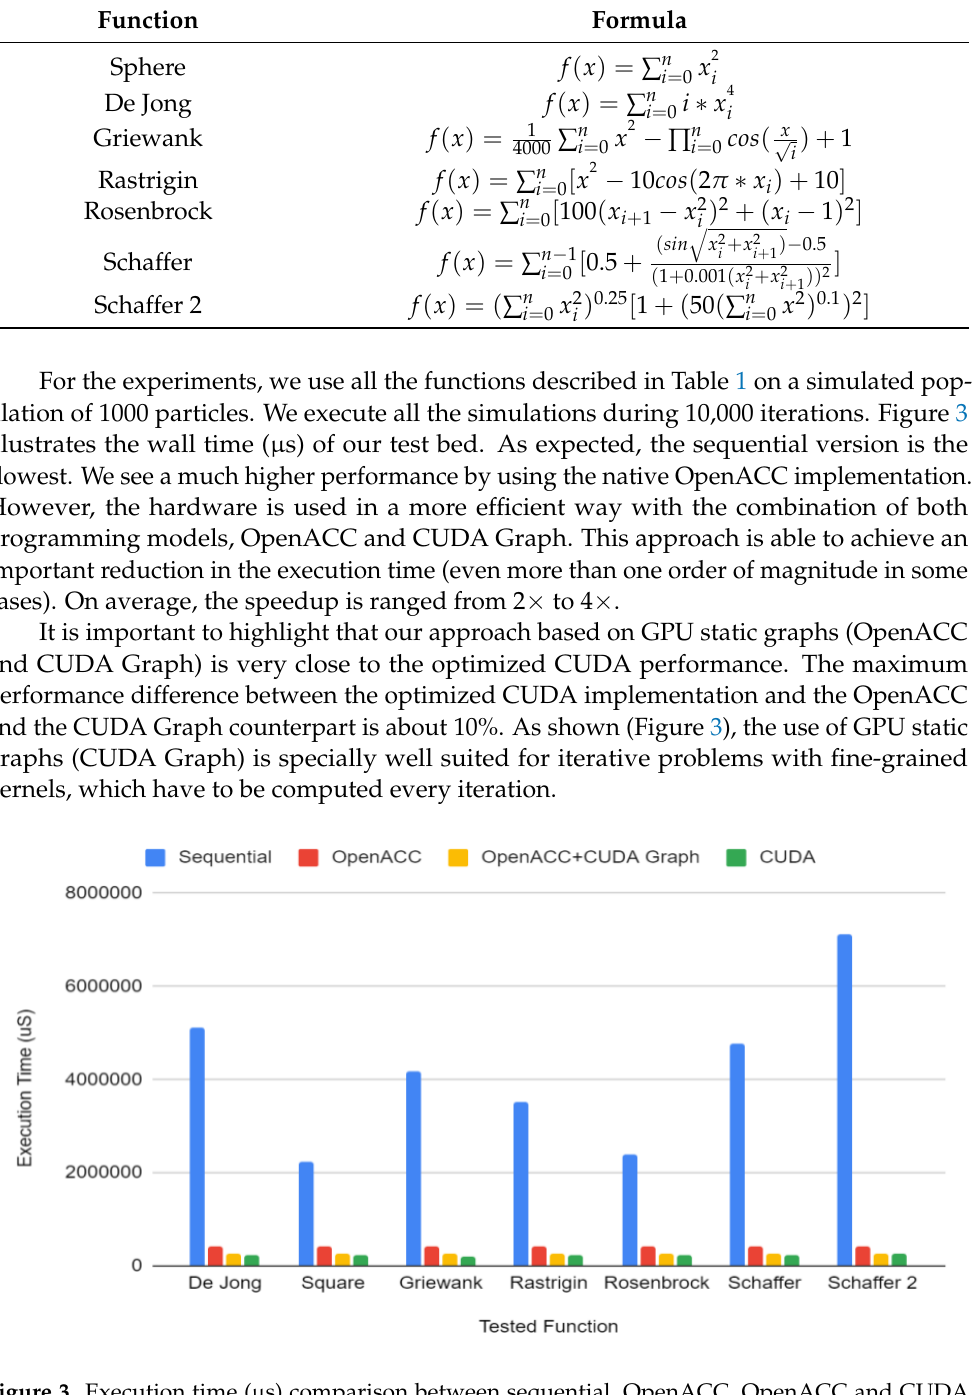
Figure 3. Execution time ( µ s) comparison between sequential, OpenACC, OpenACC and CUDA Graph and CUDA implementations of the PSO